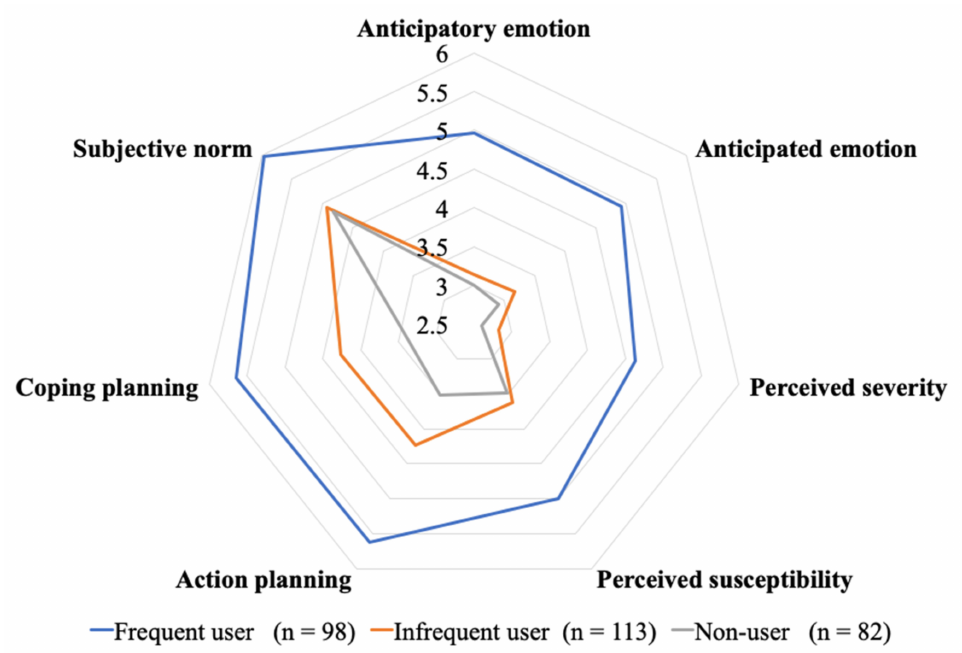
Figure 2. Descriptive statistics (frequent, infrequent, and